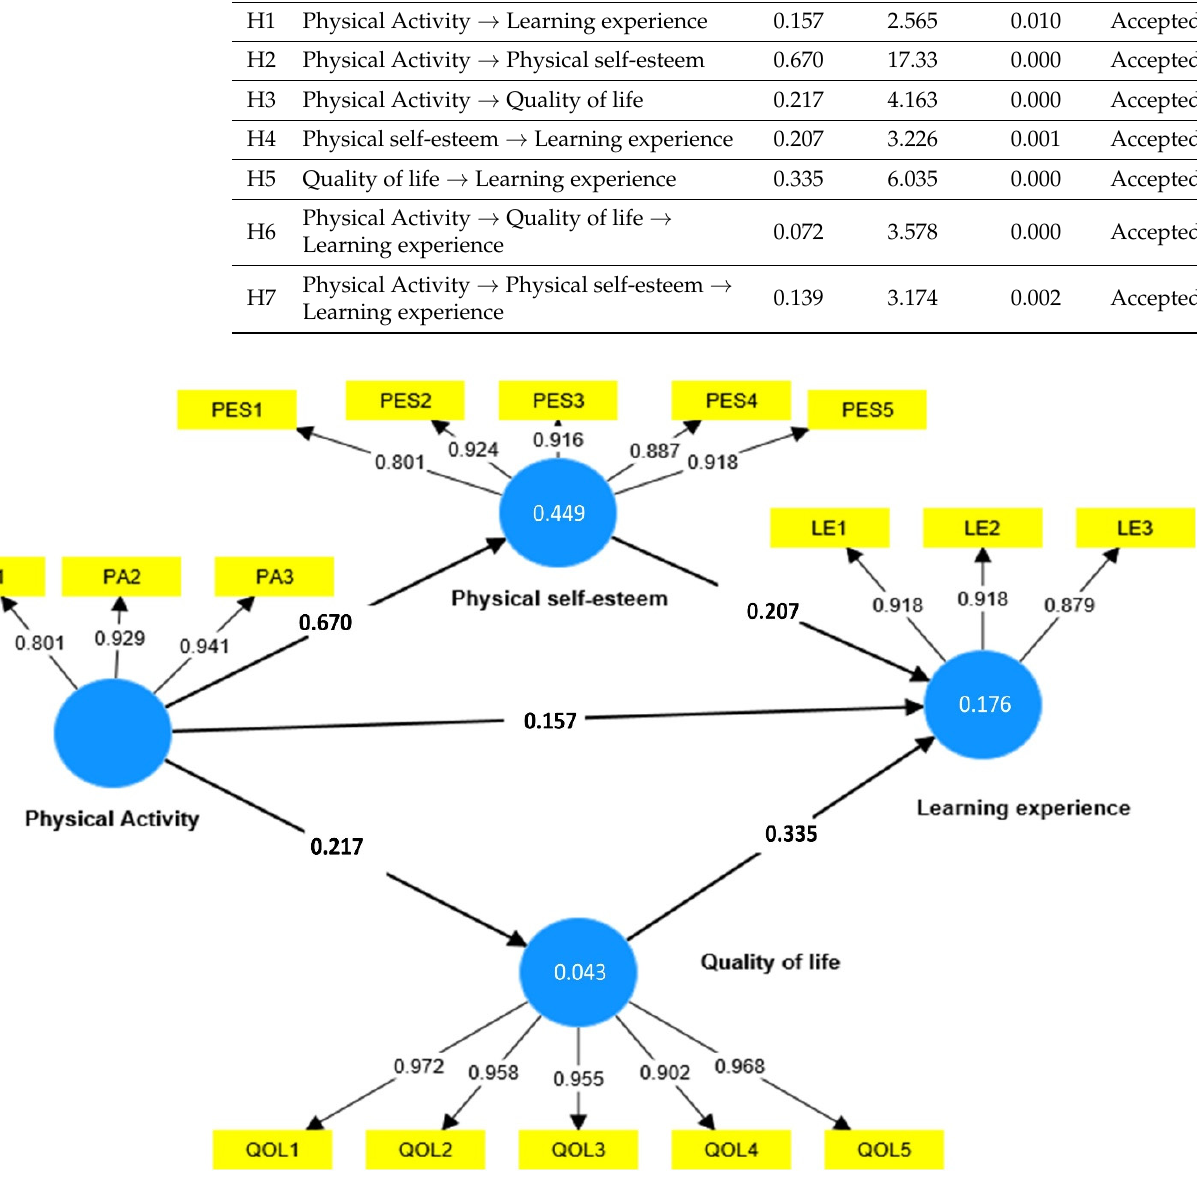
Figure 2. Structural and Measurement